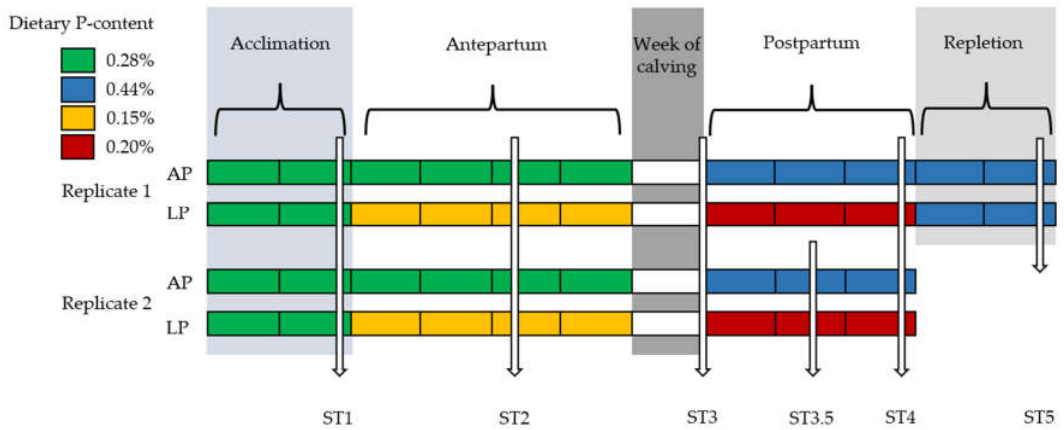
Figure 1. Experimental timeline for adequate-phosphorus (AP; n = 18) and low-phosphorus (LP; n = 18) treatments. Each rectangle represents one week. P content on a dry matter basis can be found in the legend. Week of calving is shown in white. During acclimation, cows in both treatments received the same dry cow diet with adequate P supply. Vertical arrows represent the sampling times at which the erythron and liver were